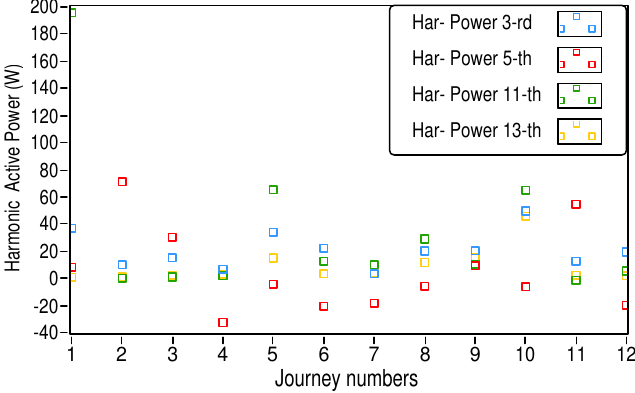
Figure 15. Trend of network influences. Harmonic active power, 3rd, 5th, 11th and 13th